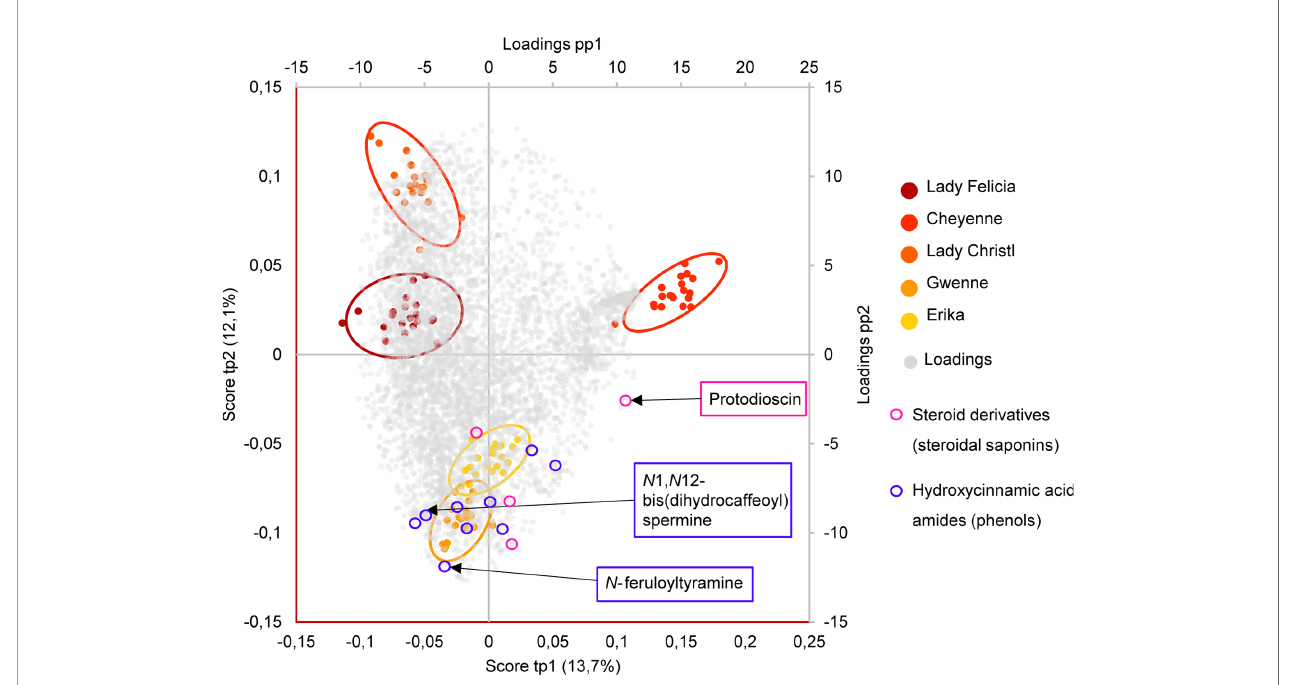
FIGURE 6 | Biplot representation of the two fi rst predictive components of the AMOPLS model in negative ion mode explaining 25,9% of the total variance. Observations are color-coded as cultivars (n=20) with 95% con fi dence ellipses and positioned according to the left and below axis. Loadings are colored in grey and positioned according to the right and above axis. Resistant cultivars (Erika and Gwenne) have negative scores of tp2, while susceptible cultivars (Lady Felicia, Cheyenne, and Lady Christl) have positive scores of tp2. The loadings of highlighted resistance-related metabolites annotated as hydroxycinnamic acid amides (including N -feruloyltyramine and N 1, N 12-bis(dihydrocaffeoyl) spermine) and as steroid derivatives (including protodioscin) are indicated in blue and pink,